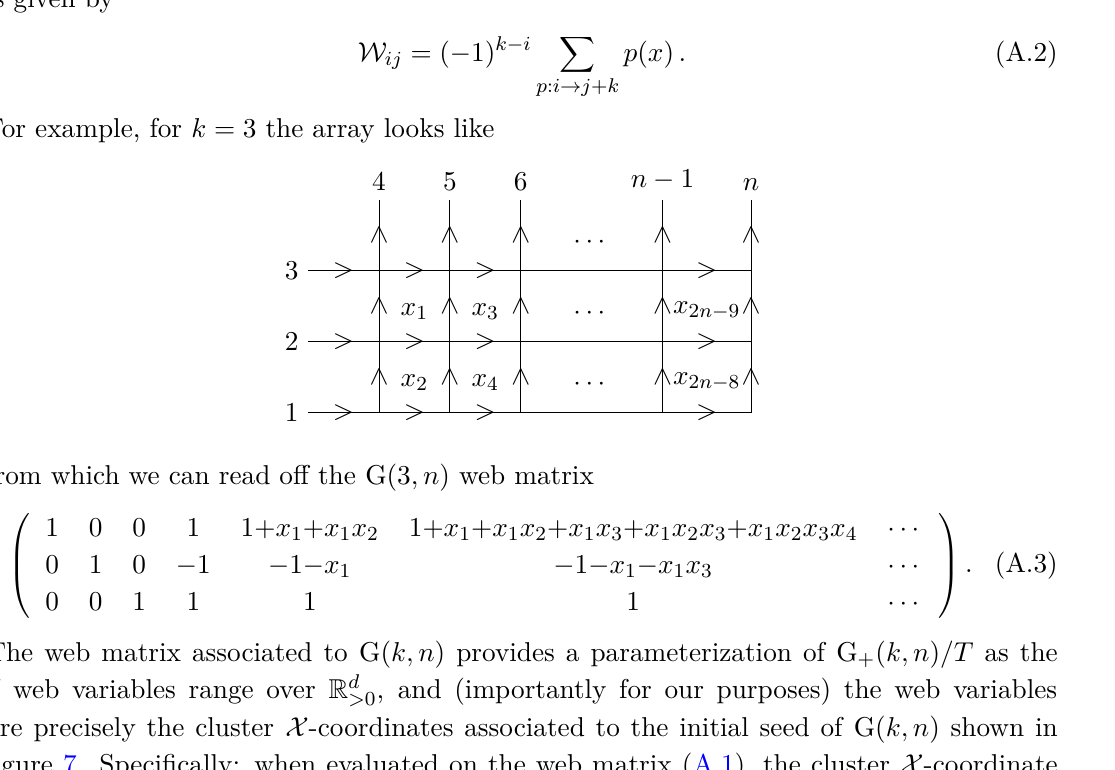
figure 7. Specifically: when evaluated on the web matrix (A.1), the cluster X -coordinate (see section A.3) attached to any mutable node of the initial quiver is equal to the web variable x that appears in the same position of the web array described